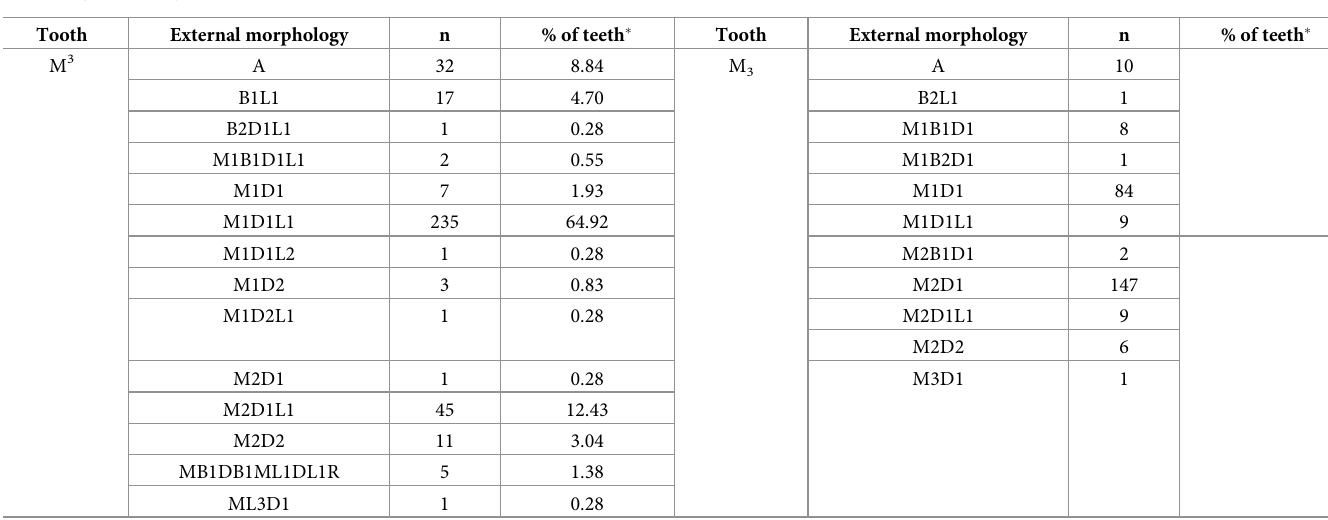
� From Table 2. Congenitally absent teeth not included in statistics for this table. A = axial, M = mesial, B = Buccal, D = Distal, L = Lingual.